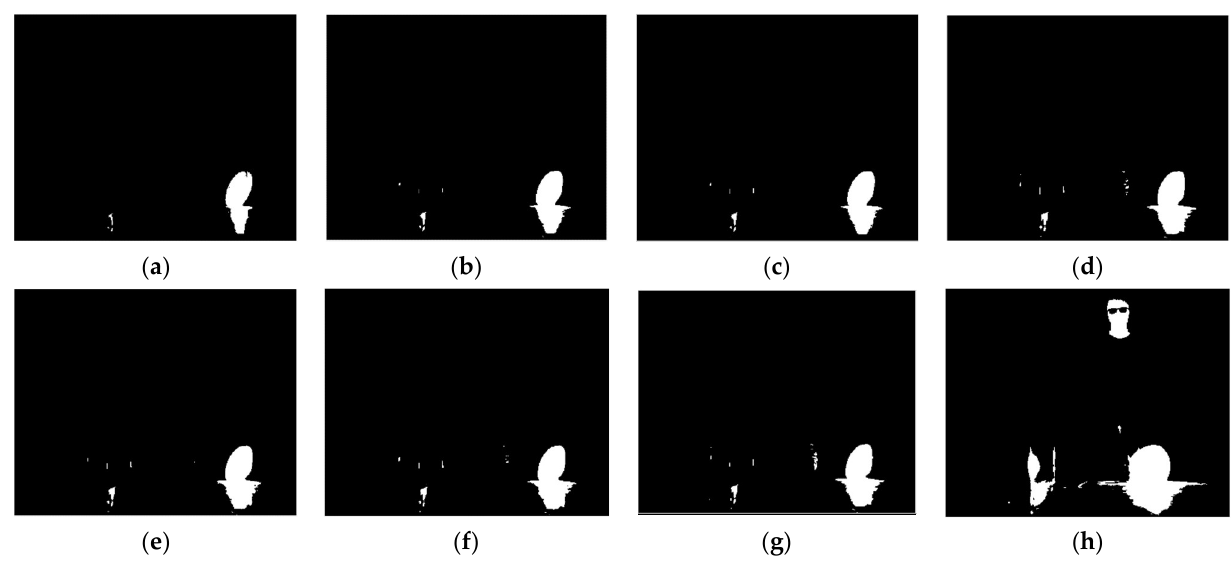
Figure 8. Image sequence obtained based on region-growing point segmentation: ( a ) 13 μs; ( b ) 67 μs; ( c ) 133 μs; ( d ) 332 μs; ( e ) 665 μs; ( f ) 1330 μs; ( g ) 1995 μs; ( h ) 3990 μs. By traversing the multi-integration sequence of images, we calculate the average grayscale of the high-temperature region of every image, I T ( i , j ) , and Equation (5) is applied to calculate the distance between average grayscale I T ( i , j ) and medium grayscale, which means that every image corresponding to an integration time would get its corresponding grayscale distance. Then, bubble sorting is used to rank these distances and determines the closest distance to the medium grayscale; its corresponding image is called the local optimum image of the high-temperature region I h . This ensures detailed imaging of the high-temperature region. The image selection process for the ambient-temperature region is similar to the aforementioned method; the only difference is the average grayscale of the ambient-temperature region of every image, I T ( i , j ) , is calculated, which obtains the result called the local optimum image of the ambient-temperature region I l . That is, when choosing I h , the high-temperature region R H is applied in “ region ”; when choosing I l , the ambient-temperature region R L is applied in “ region ”.